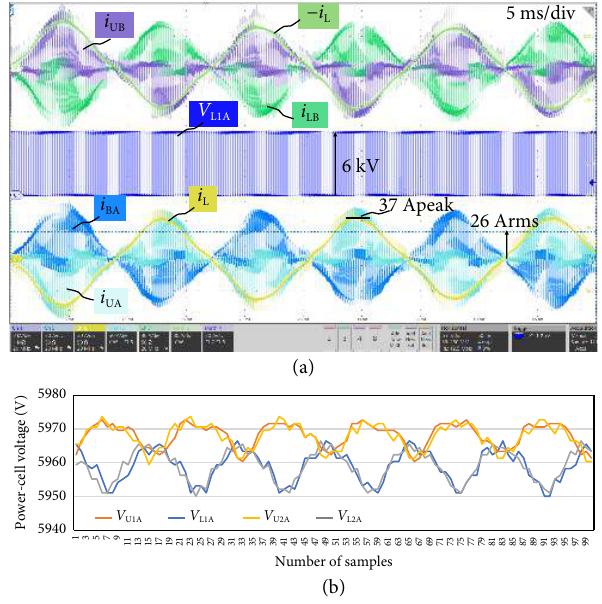
Fig. 15 SCC dc-dc operation mode at V dc = 12 kV and i L = 24 A at D = 0.5, phase shift (PH) = 90° and PH = 270°: (a) waveforms, (b) power-cell voltages collected through communication network.